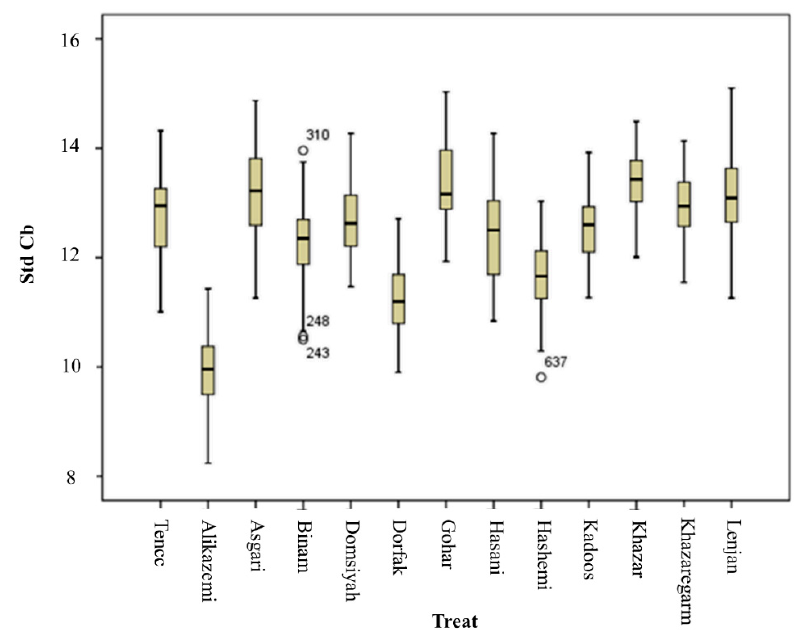
Figure 3. The box plot of Cb-standard deviation for 13 white rice cultivars.